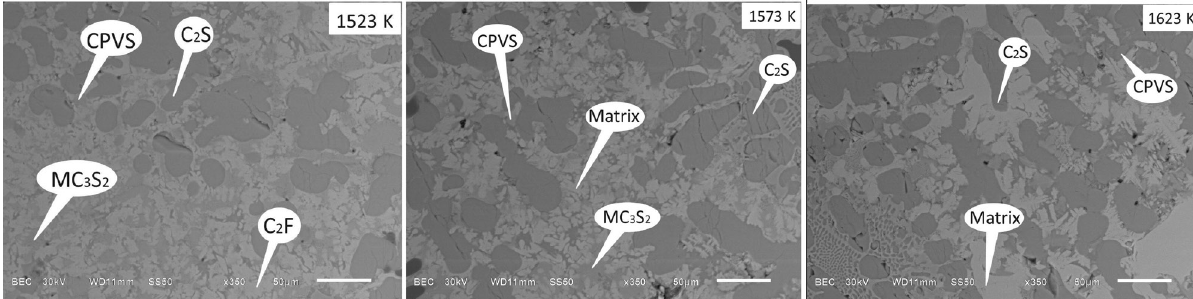
Fig. 3: SEM images for sample 2 quenched at different temperature